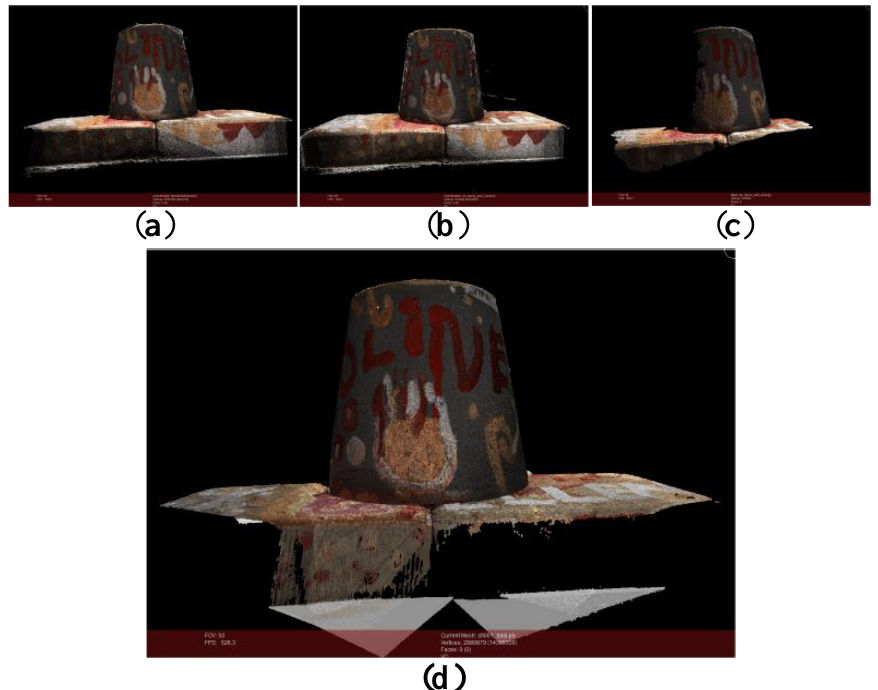
Figure 7. Point cloud comparison. ( a ) Point cloud of our method ( m = 15, k = 6); ( b ) Point cloud of openMVG + openMVS; ( c ) Point cloud of MicMac; ( d ) Standard point cloud.